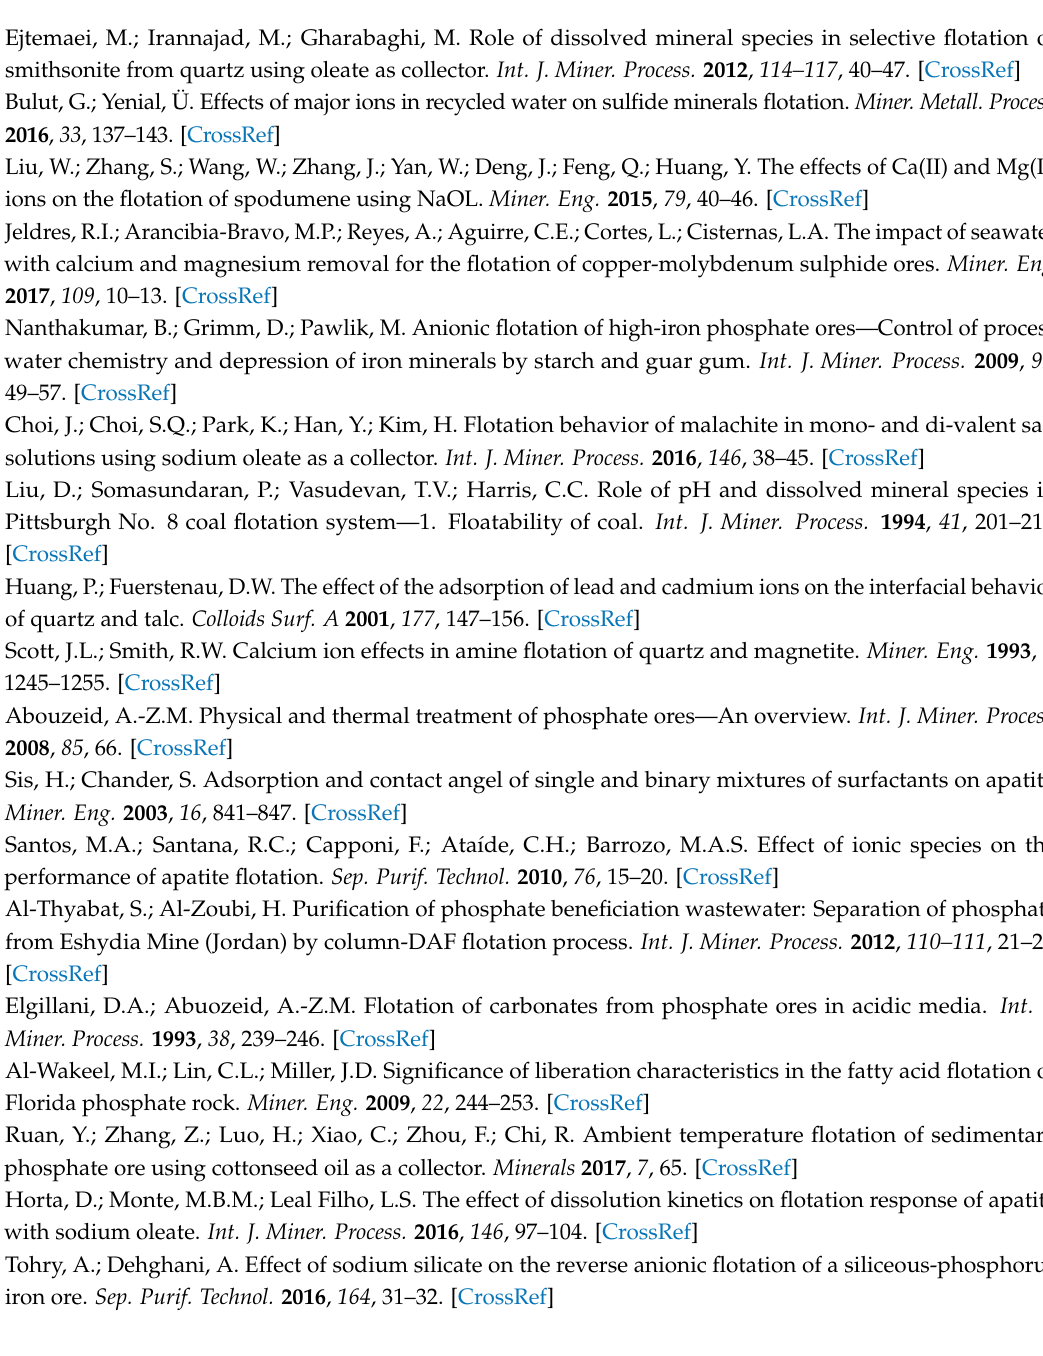
Table S1: Parameters of C1 s on apatite surface treated with various conditions; Table S2: Parameters of C1 s on dolomite surface treated with various conditions; Table S3: Parameters of C1 s on quartz surface treated with various